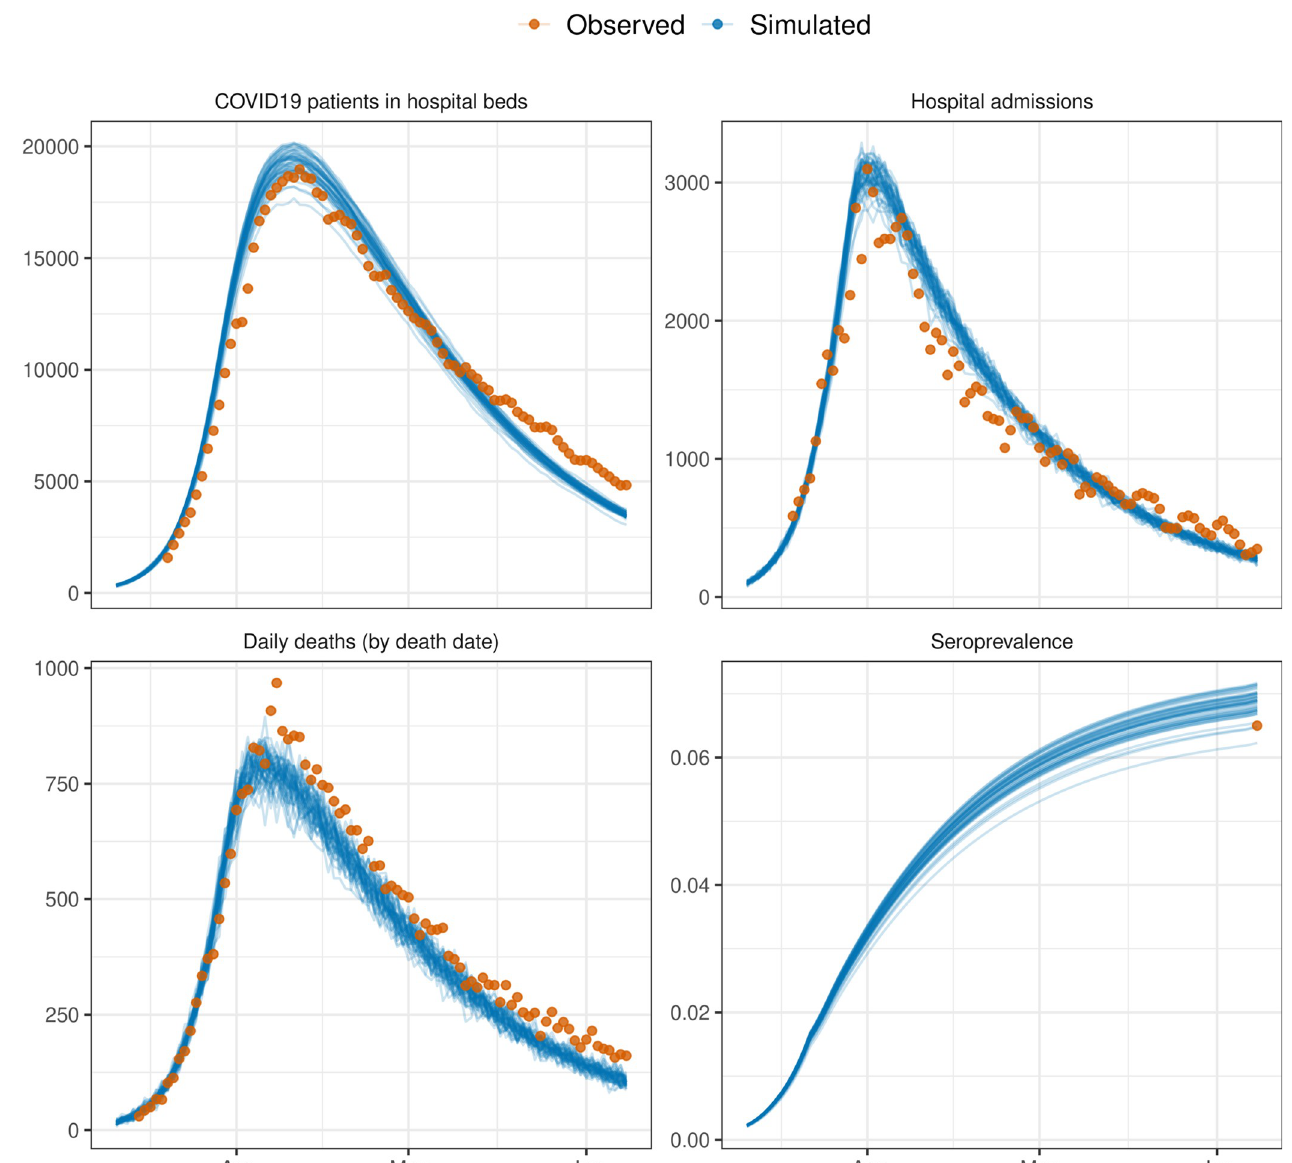
Fig 5. Example of model outputs from OpenABM-Covid19 compared to observed data from the first wave in England. Simulations are from 50 simulations in a population of 56 million individuals with UK-like demographics and control interventions. The beginning of the national lockdown is 23rd March 2020. Overlaid data are provisional counts of the number of deaths (measured by date of death) involving the coronavirus (COVID-19) registered in England (accessed on 5th June 2020), COVID19 patients in hospital beds (England), daily hospital admissions (England) from the UK government’s COVID19 dashboard, and estimates of seroprevalence in England from the UK Office of National Statistics. Simulations are not calibrated to hospitalisation data, only shown for